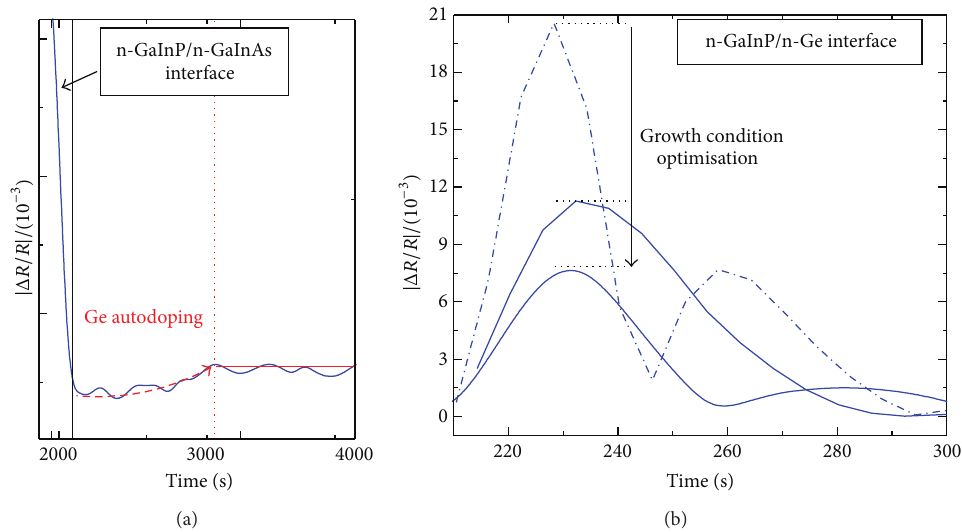
Figure 4: The in situ record of the single-wavelength (3.8eV) RA signal: (a) during GaInAs buffer growth (Ge autodoping suppression is shown) and (b) during GaInP on Ge nucleation (optimization interface quality is